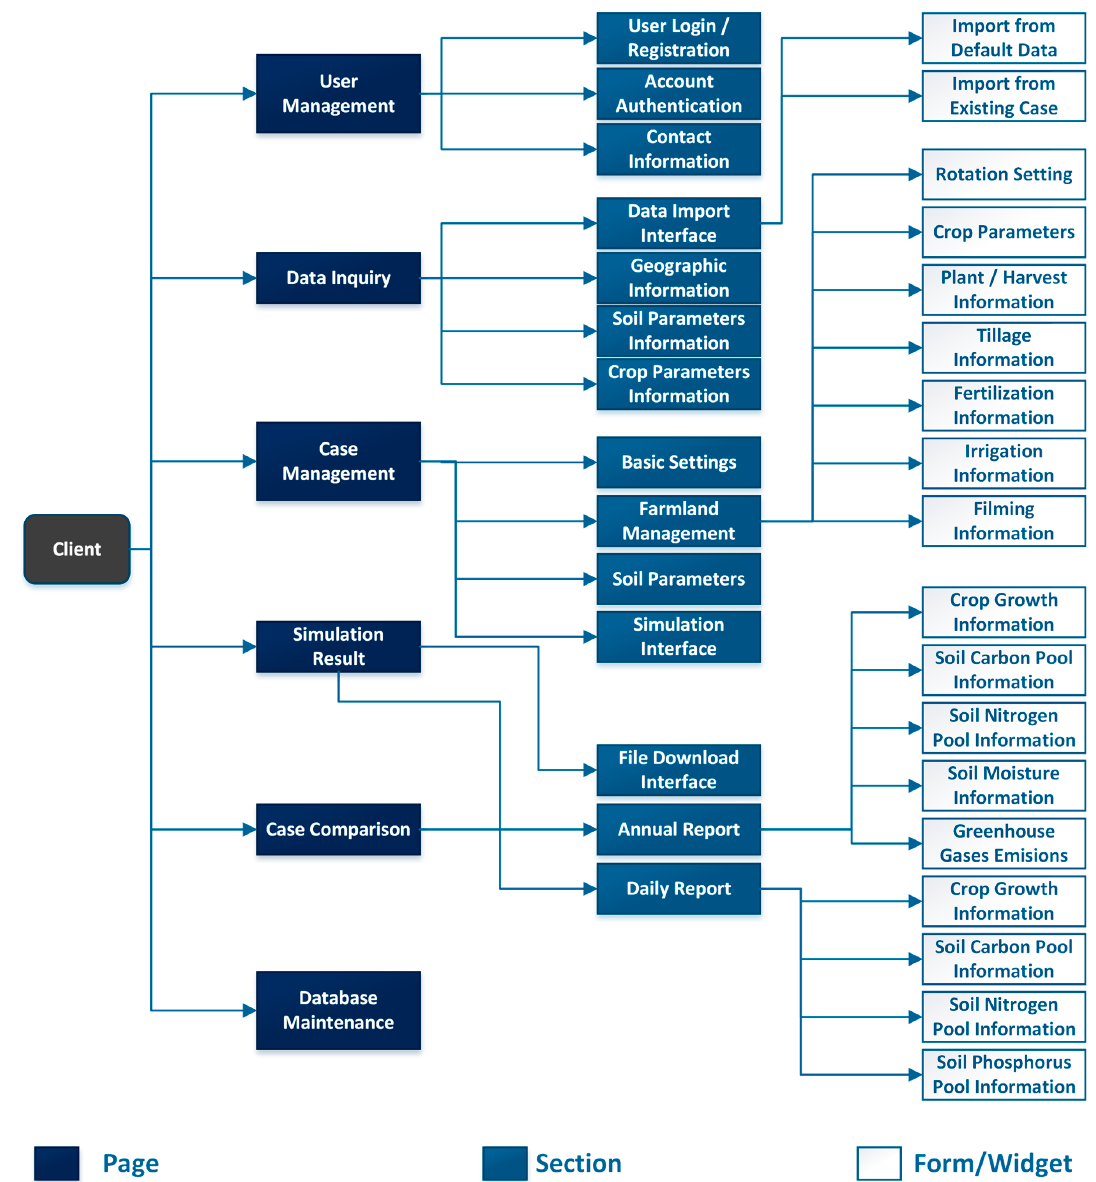
Figure 3. Structure of the DNDC online model’s user interface.